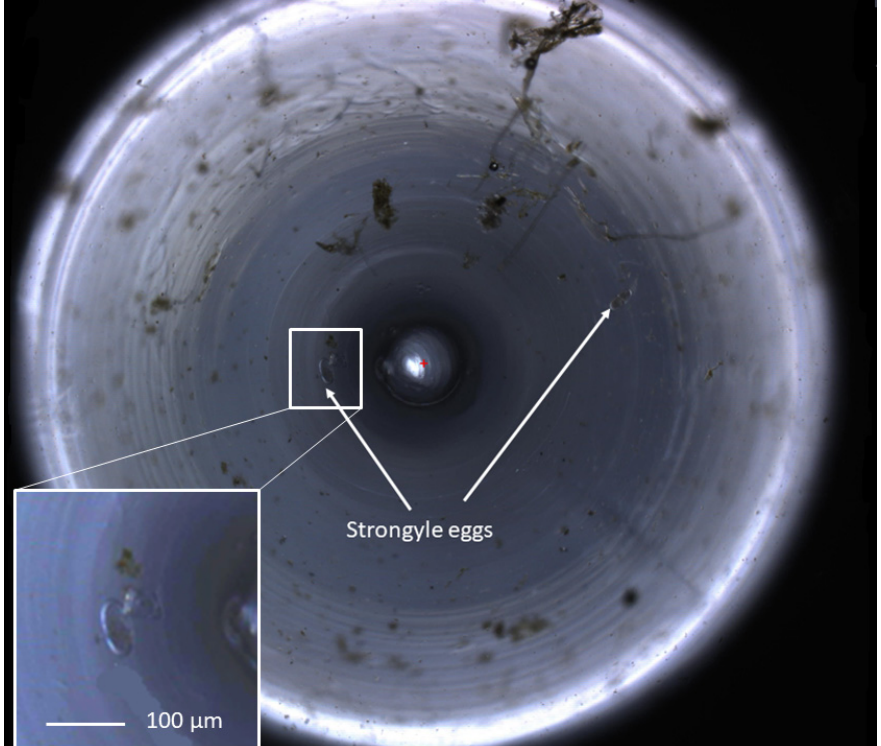
Figure 2. A zoomed-out view of an equine faecal egg count imaged using the FECPAK G2 Micro-I. The circular image demonstrates a 3 mm field of view at the top of the meniscus produced in the FECPAK G2 Micro-I cassette. Helminth eggs in a flotation solution accumulate to the centre of the well, following the shape of the meniscus. The central circle represents the tip of the light source within the cassette. Equine strongyle eggs are highlighted with white arrows. One of two images produced for each G2 cassette, with each helminth egg seen over the combined two images representing 45 epg, calculated from the dilution factor and the volume of the FECPAK G2 cassette. These images are visible only to the technicians who identify the eggs, and they are large file sizes so they can be zoomed in without loss of clarity in order for accurate identification of helminth eggs.